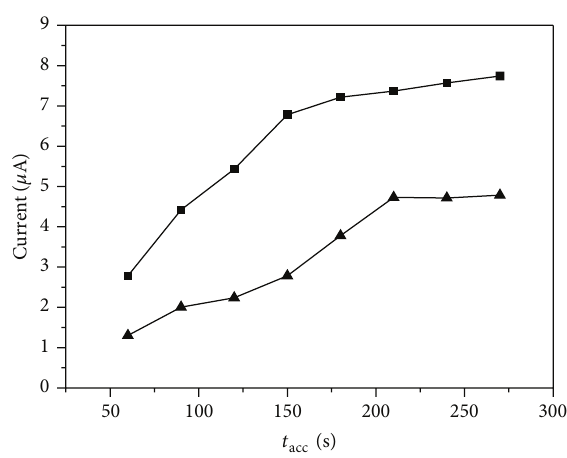
Figure 7: The dependence of the stripping current of Ge(IV)- pyrogallol complex on the accumulation time, pyrogallol concen- tration 1.3 × 10 −3 molL −1 , 5 𝜇 g L −1 ( 󳵳 ) Ge(IV), and 10 𝜇 g L −1 ( ◼ ) Ge(IV). Other conditions as in Figure 1.